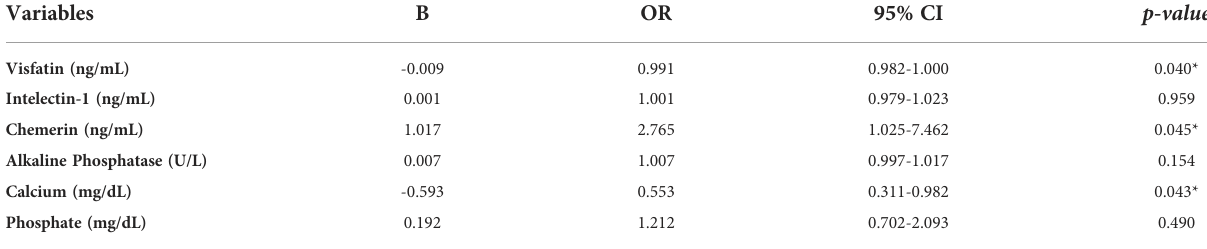
TABLE 3 Logistic regression analysis showing factors associated with BMD.